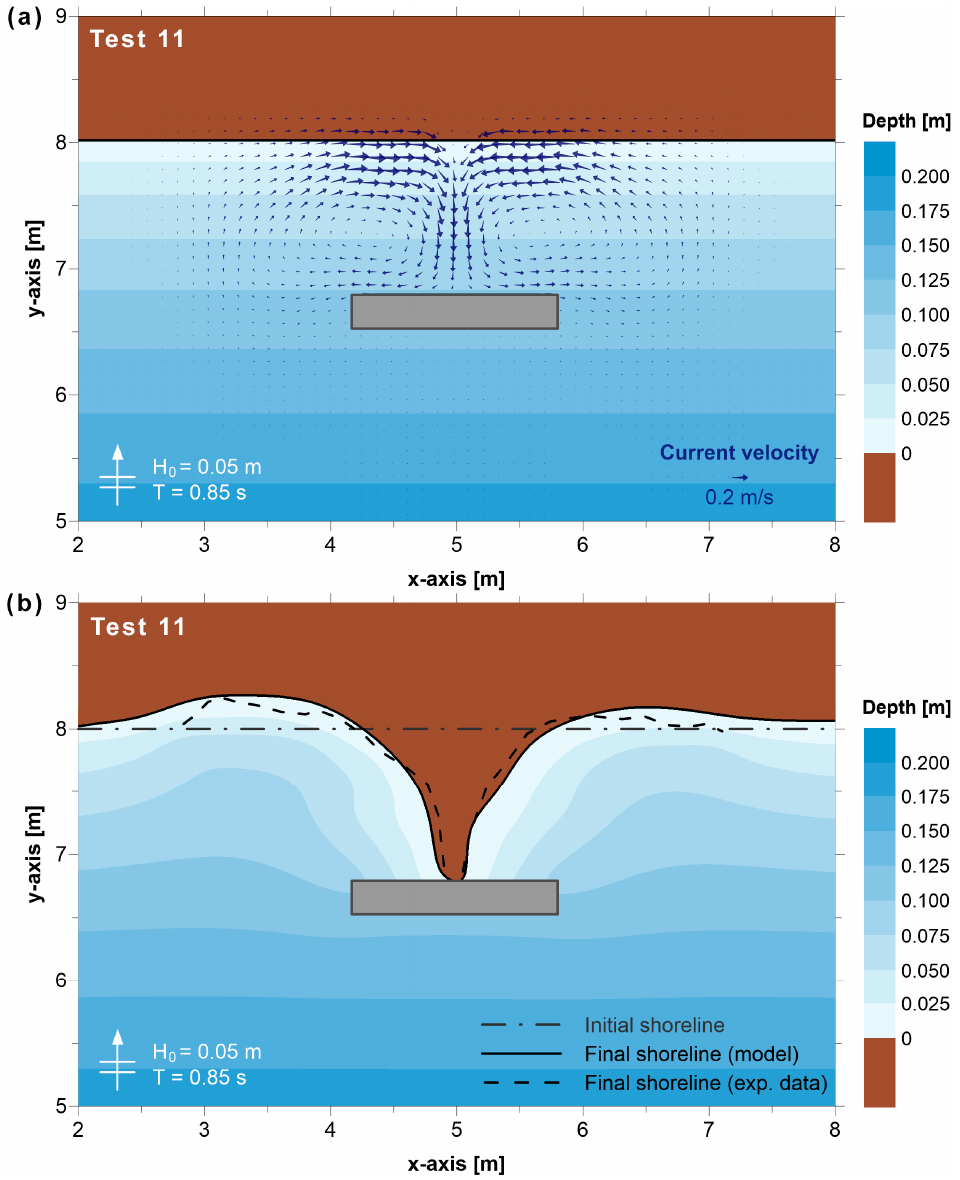
Figure 2. ( a ) Initial wave-induced current velocity field (contours represent the initial bathymetry) and ( b ) comparison between the computed and measured shoreline evolution (contours represent the final computed bathymetry) for Test 11 of Ming and Chiew [21].